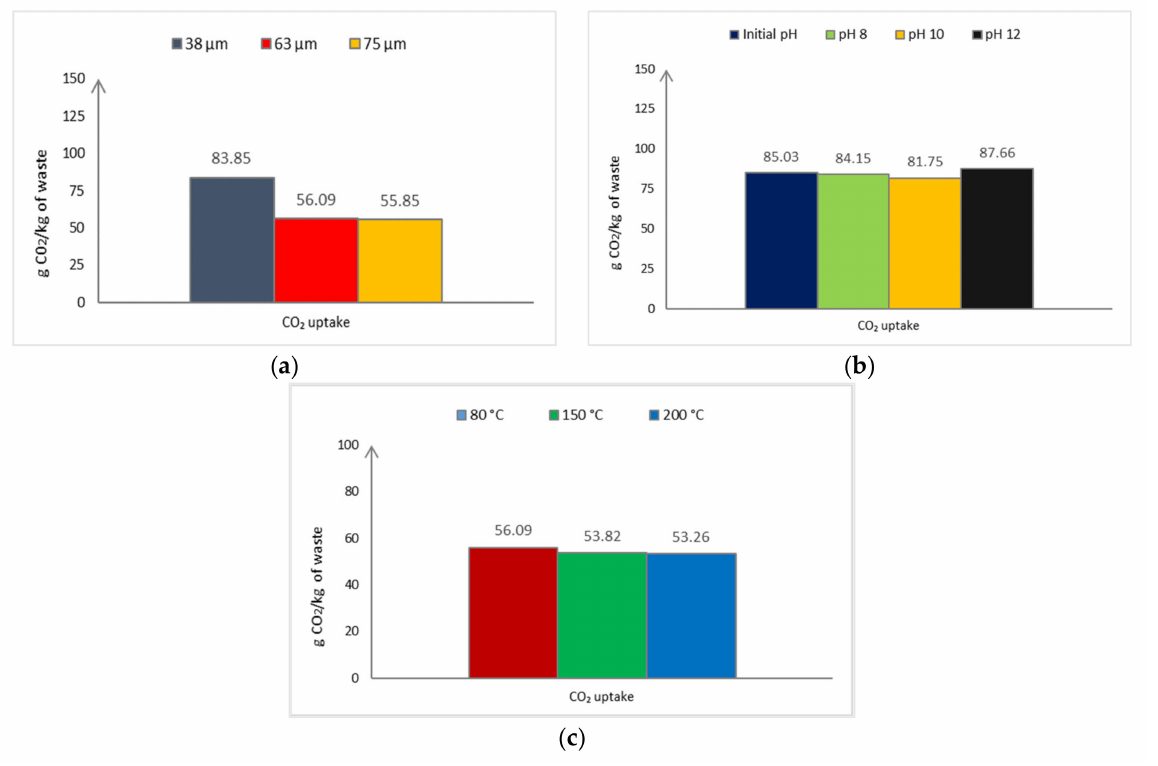
Figure 10. Carbon capture capacity (g/kg of waste) of Fe − rich mine waste in different ( a ) particle size, ( b ) pH condition and ( c ) reaction